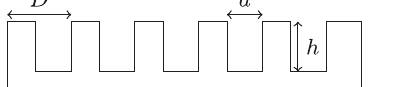
FIG. 12. Geometry of the